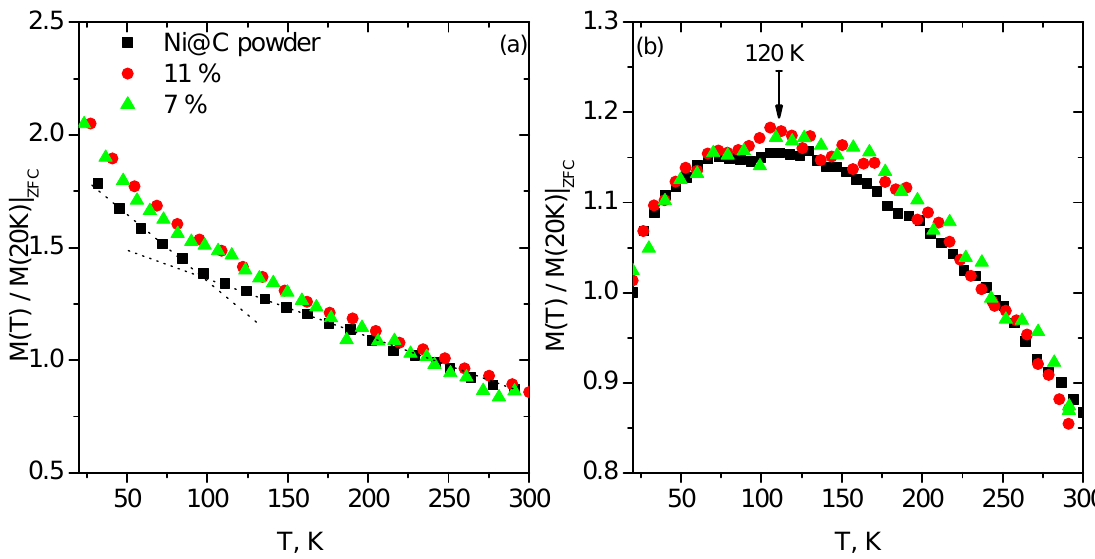
Figure 7. FC ( a ) and ZFC ( b ) dependencies of the relative magnetization as M(T)/M(T = 20 K) | ZFC for Ni@C powder and for composite samples with different concentrations of Ni@C measured at 117